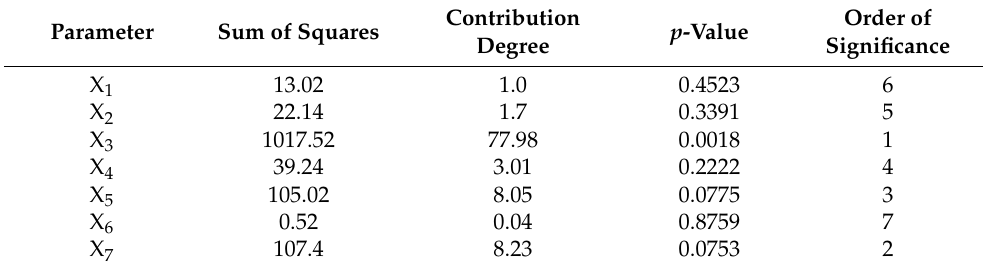
Table 4. Analysis of significant of parameters in the Plackett–Burman